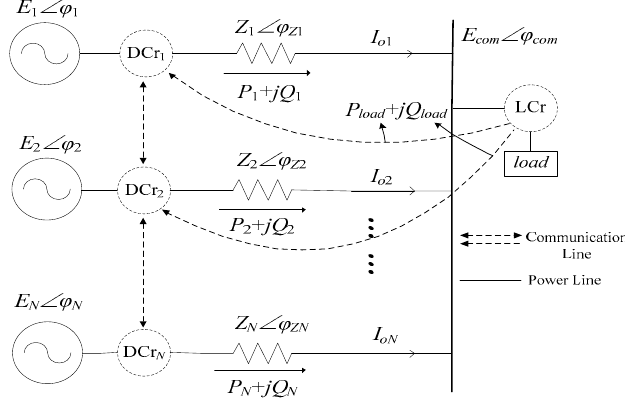
Figure 1. Equivalent model of many sets of distributed generators connected in parallel.